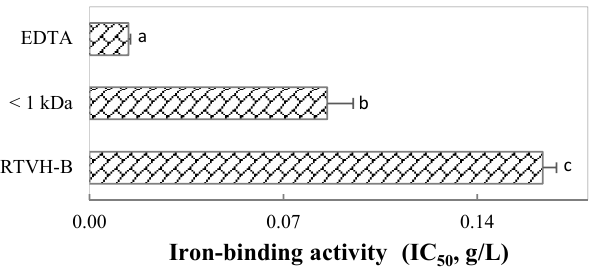
Figure 4. IC 50 of RTVH-B, its fraction FRTVH-V, and EDTA. Different superscript letters denote Figure 4. IC 50 ofRTVH-B,itsfractionFRTVH-V,andEDTA.Differentsuperscriptlettersdenotestatistically statistically significant differences among treatments ( p < 0.05). significant differences among treatments ( p < 0.05).